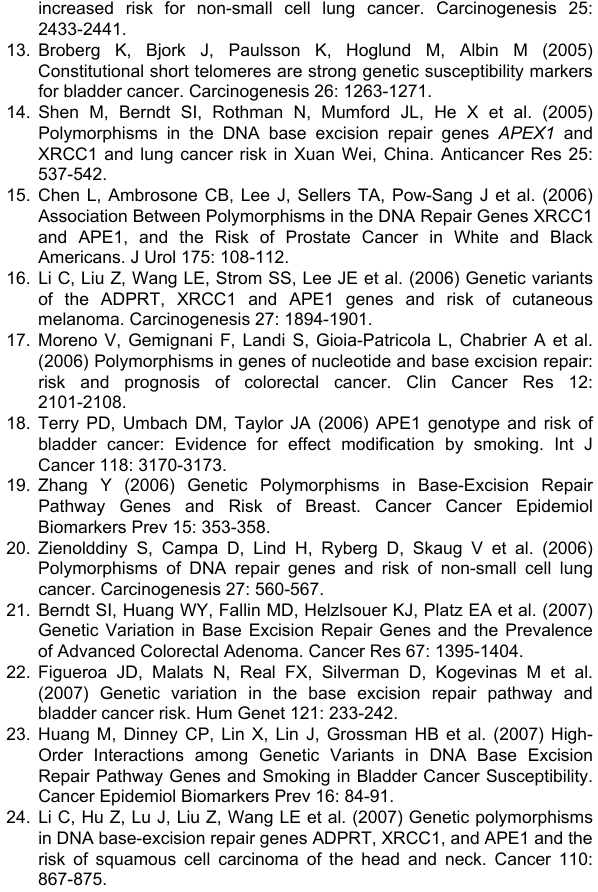
Figure S3. Forest plots of the hospital-based studies (the upper panel), and population-based studies (the lower panel) in subgroup analyses by study design for the APEX1 Asp148Glu polymorphism under the allelic model.